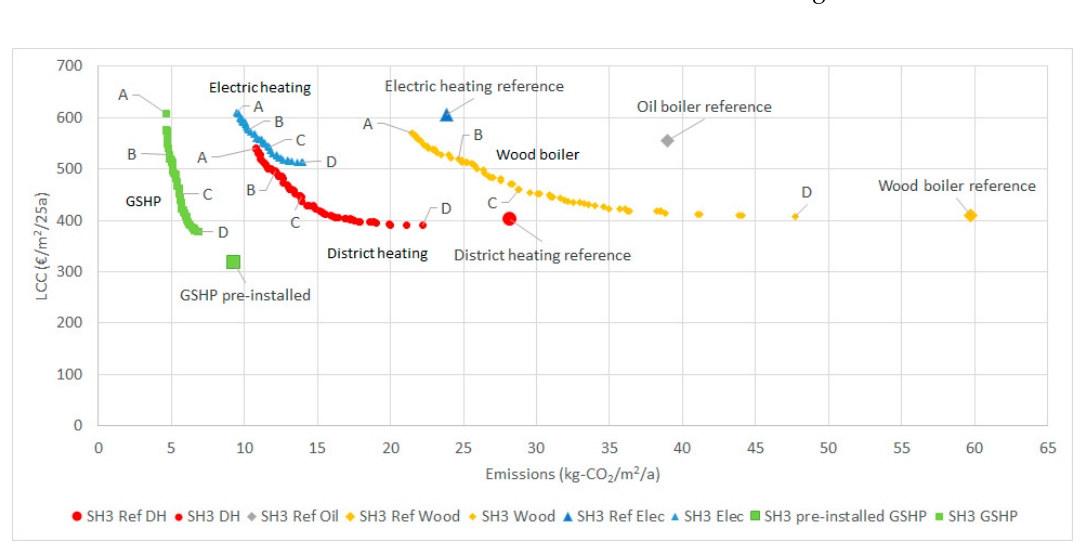
Figure 10. Reference cases and optimal results for the single-family house SH3 with different heating systems.